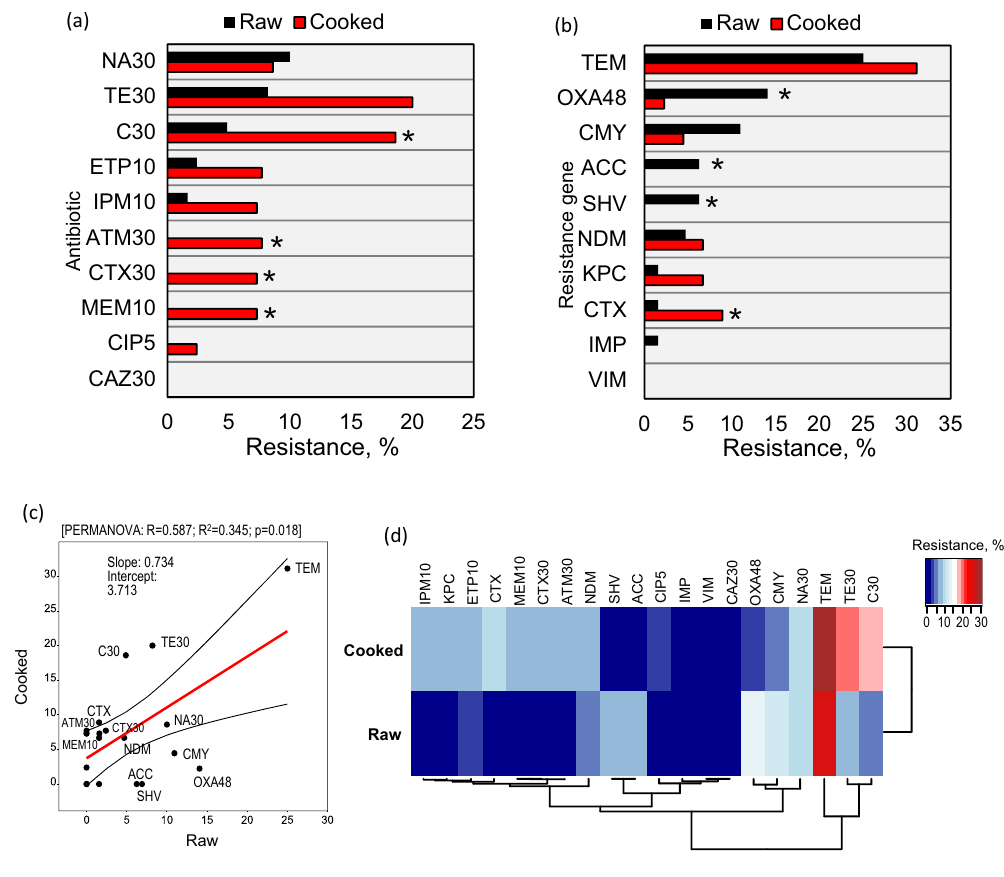
Figure 1. Differences in the prevalence of antibiotic-resistant bacteria in raw versus cooked shrimp. ( a ) Percentage resistance observed in isolates from cooked and raw shrimp samples by disc diffusion assay. ( b ) Real-time multiplex PCR assay for the detection of ESBLs and carbapenem genes. Isolates from cooked sample (n = 45) and raw samples (n = 62). ( c ) Generalized linear model demonstrating the profiles of antibiotic resistance percentage and the prevalence of resistance genes between raw versus cooked shrimp. ( d ) Heatmap clustering analysis showing the clusters of antibiotic resistance profiles and the resistant genes in raw versus cooked shrimp. Aztreonam (ATM-30), Cefotaxime (CTX-30), Ceftazidime (CAZ-30), Imipenem (IPM-10), Ertapenem (ETP-10), Meropenem (MEM-10), Tetracycline (Te-30), Ciprofloxacin (CIP-5), Nalidixic Acid (NA- 30), Chloramphenicol (C-30). *p <